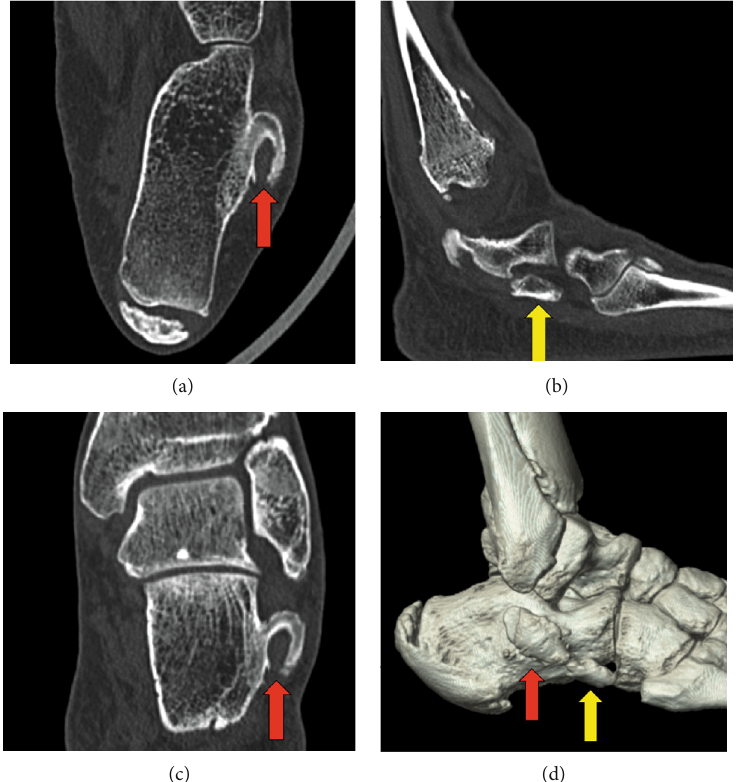
Figure 2: CT: Axial image (a), sagittal image (b), coronal image (c), and 3D image (d). Hypertrophic peroneal tubercle, a bony overgrowth surrounding a peroneal tendon (red arrow). Os peroneum, an ossicle on the outer anterior side of the calcaneus (yellow